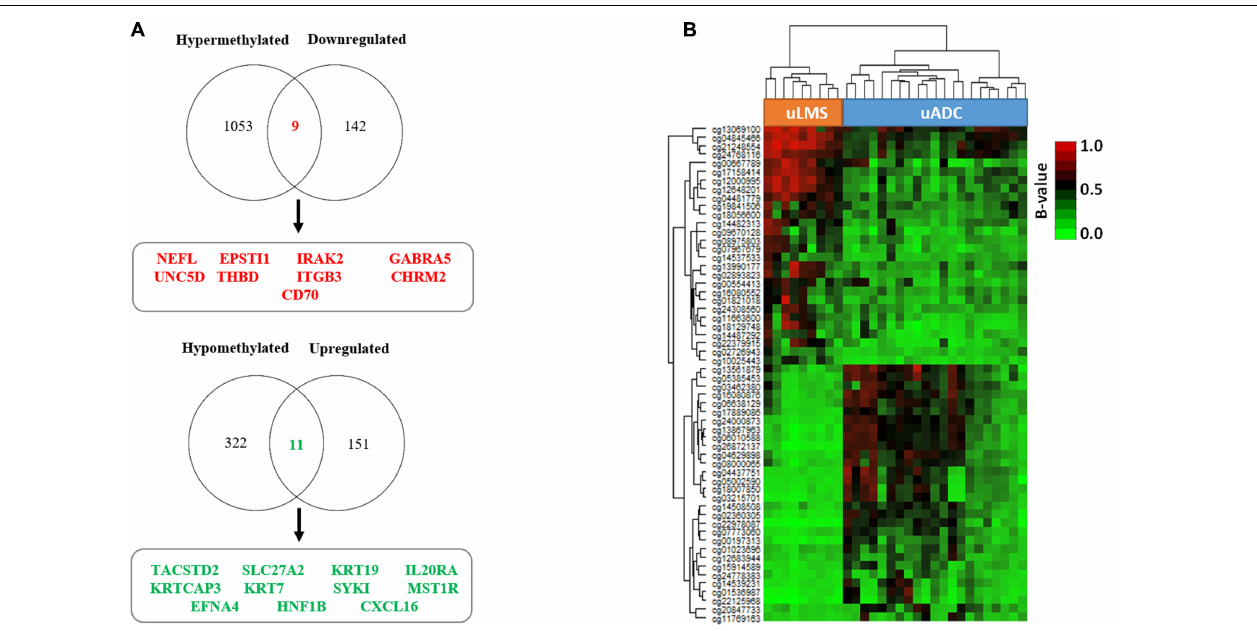
FIGURE 8 | Invasive tumor front (ITF) is defined by a 20-gene expression signature, under epigenetic regulation, in primary uterine adenocarcinomas (uADC) and leiomyosarcomas (uLMS). (A) Venn diagrams showing the differentially methylated and differentially expressed genes between the primary ITF of uADC and uLMS. The names of the nine hypermethylated and downregulated genes in uADC compared to uLMS are indicated in red, and those of the 11 hypomethylated and upregulated genes in uADC compared to uLMS are represented in green. (B) Supervised hierarchical clustering of the CpGs from promoter CGIs (corresponding to 20 genes) whose methylation status correlated with significant changes in gene expression. β -Values represent the normalized levels of DNA